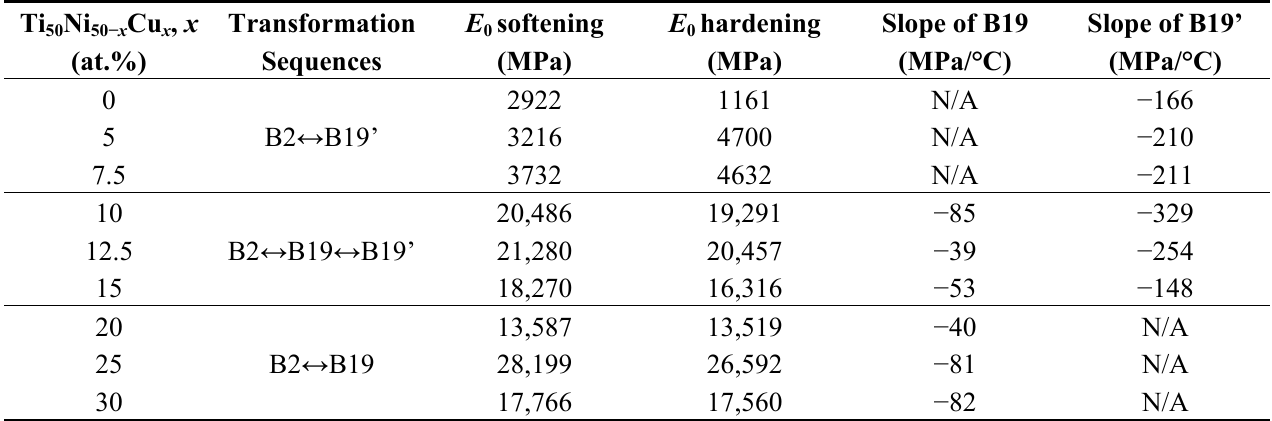
Figure 4. The schematic diagram for the definitions of the storage modulus ( E softening/hardening and the slope of E